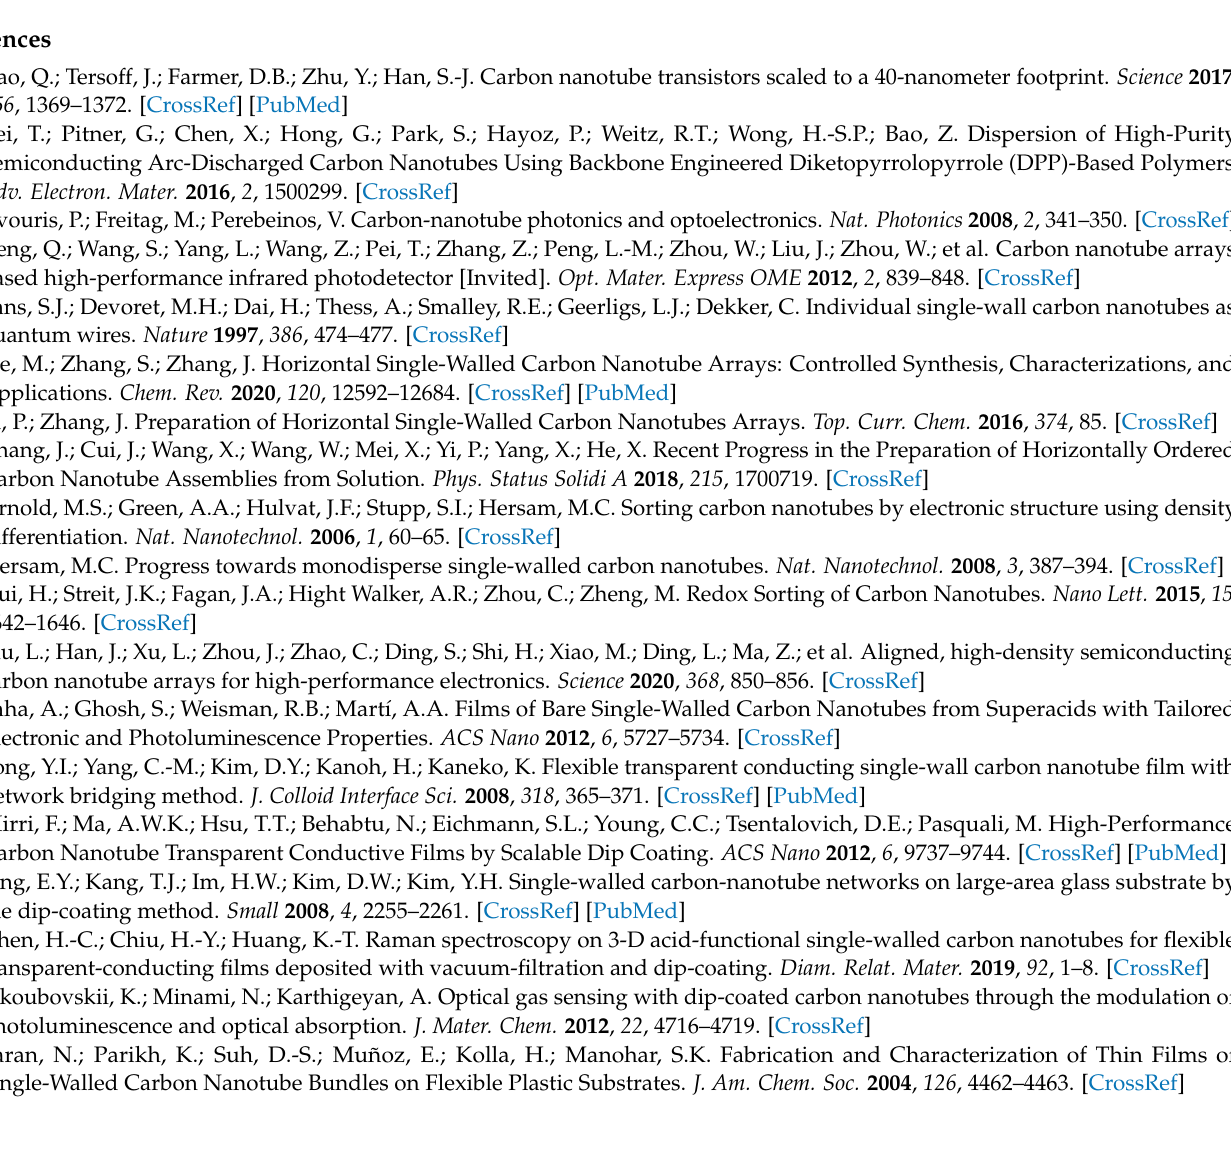
SWCNTs; Figure S2: Raman spectrum for as-prepared P3-SWCNT film added with SDS; Figure S3: SEM images to illustrate the withdrawal speed effect for P3-SWCNT films at different withdrawal